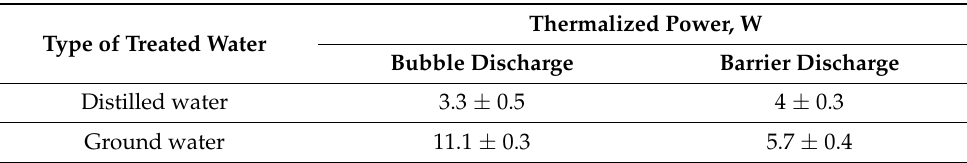
Table 1. The value of the discharge power thermalized in an aqueous solution depending on the discharge type and the type of treated water.